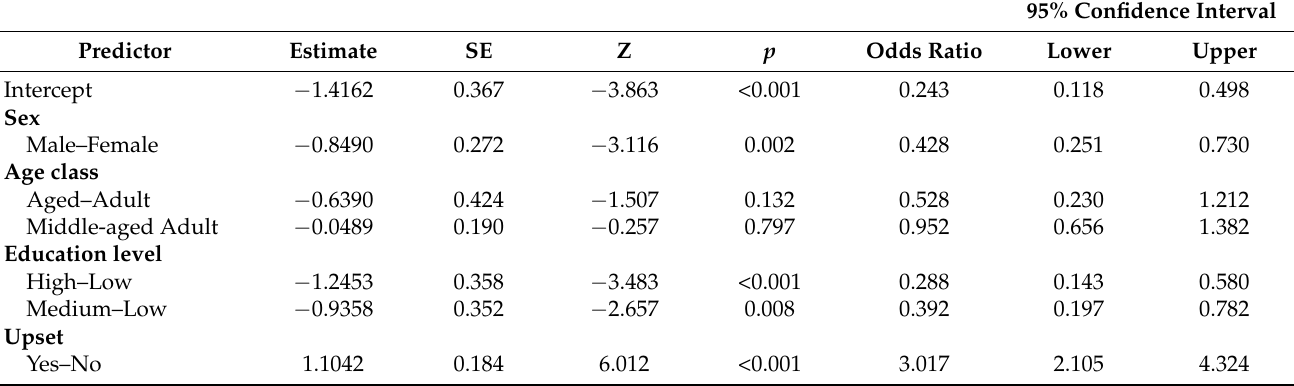
Table A5. Results of Multivariate Regression Analysis Models, with Quality of Sleep as Dependent Variable and Feeling of Upset and Sociodemographic Characteristics as Independent